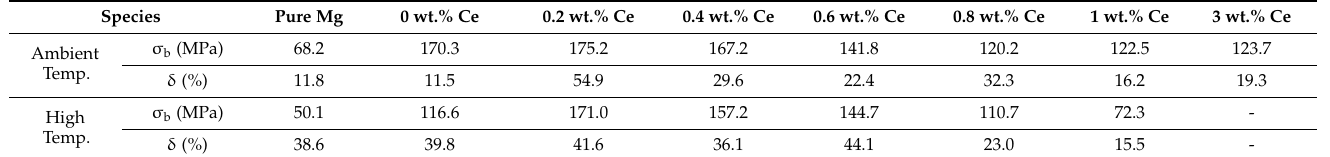
Table 5. Comparison of UTS and elongation at ambient temperature and high temperature. Species Pure